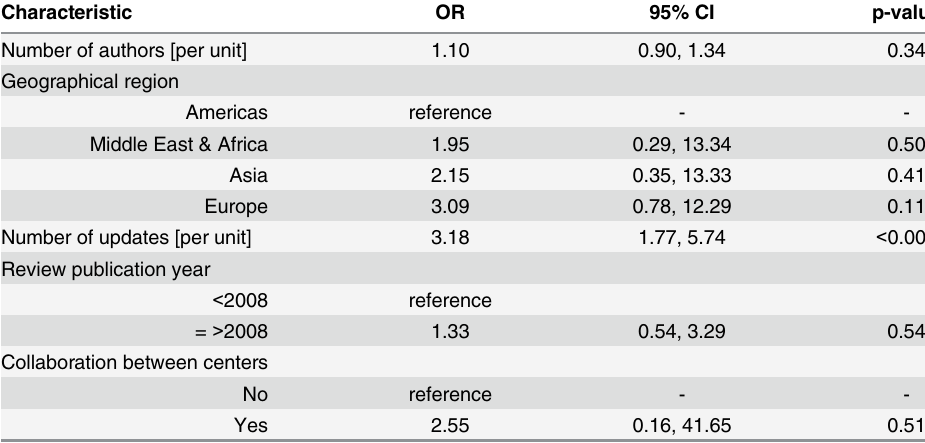
text (S3 Table). It is important to point out that not all declared changes were explained in detail or justified. Table 2. Adjusted odds ratios and associated 95% confidence intervals for the association between any discrepancies (protocol vs final report) and review characteristics.